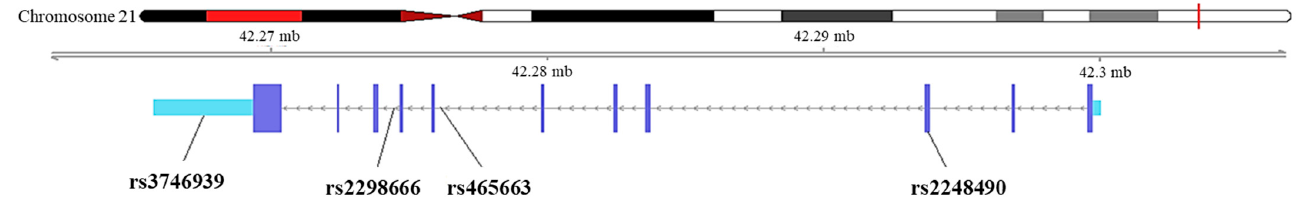
Figure 1. Graphic view of the genotyped WDR4 gene.